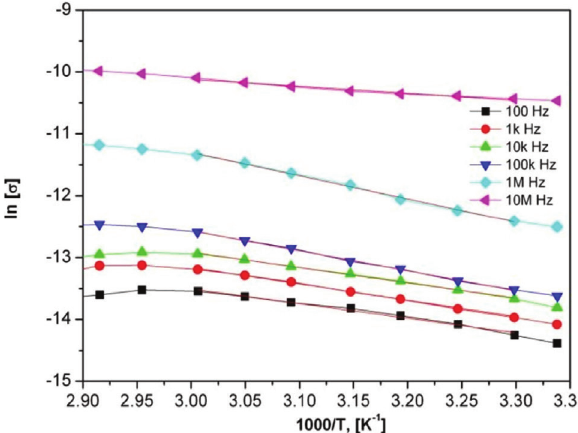
Fig. 4: Arrhenius plots of the AC conductivity for the ECTW sample at different